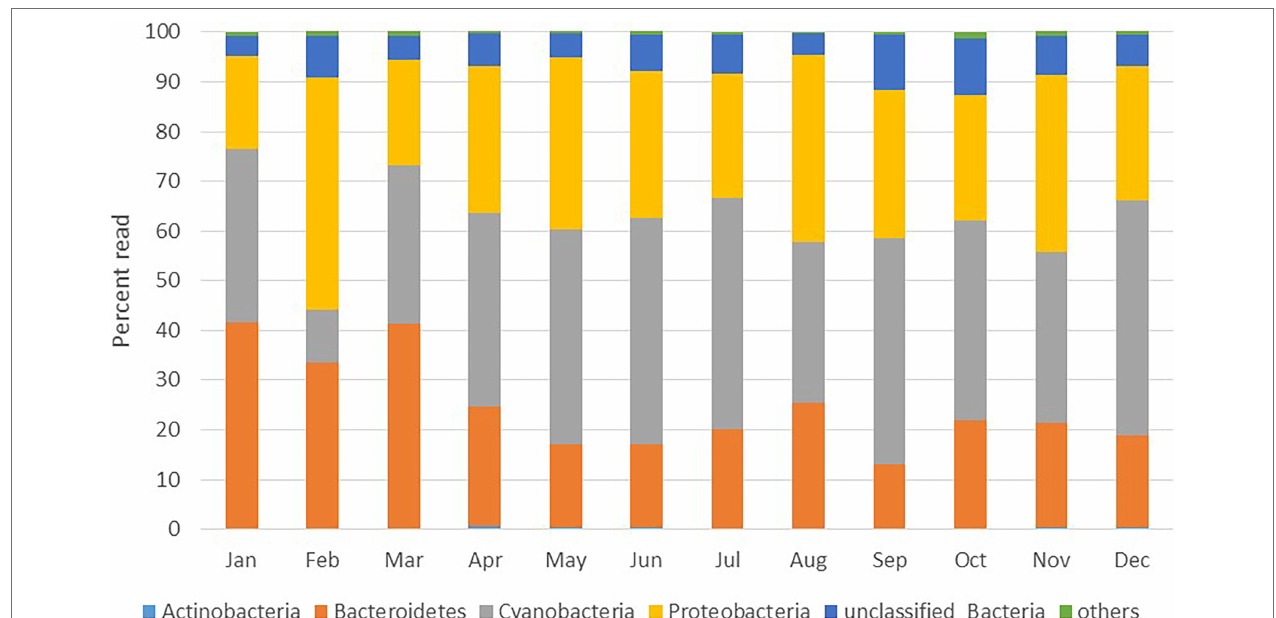
FIGURE 2 | Monthly changes in bacterial community composition at the phylum level expressed as percent of total